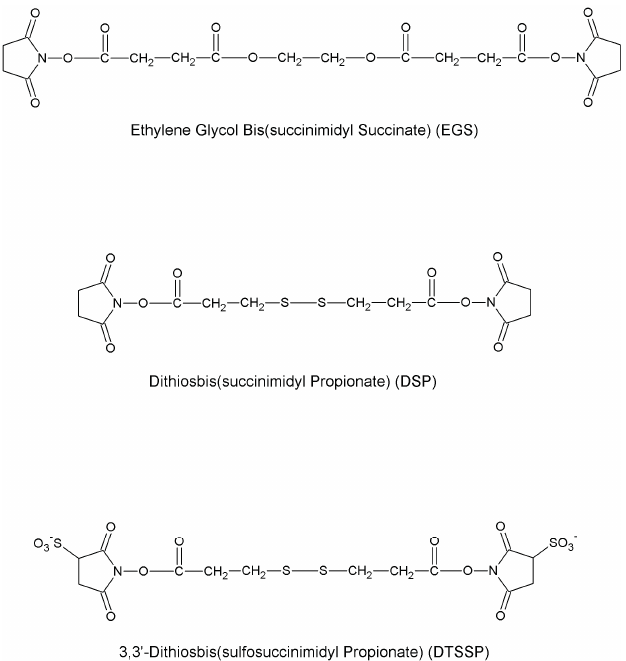
Figure 7. Several bifunctional N -hydroxysuccinimides esters containing cleavable cross-linking have been